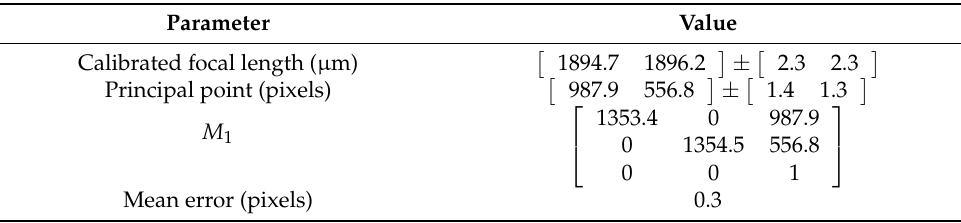
Table 3. Results of the monocular camera calibration.